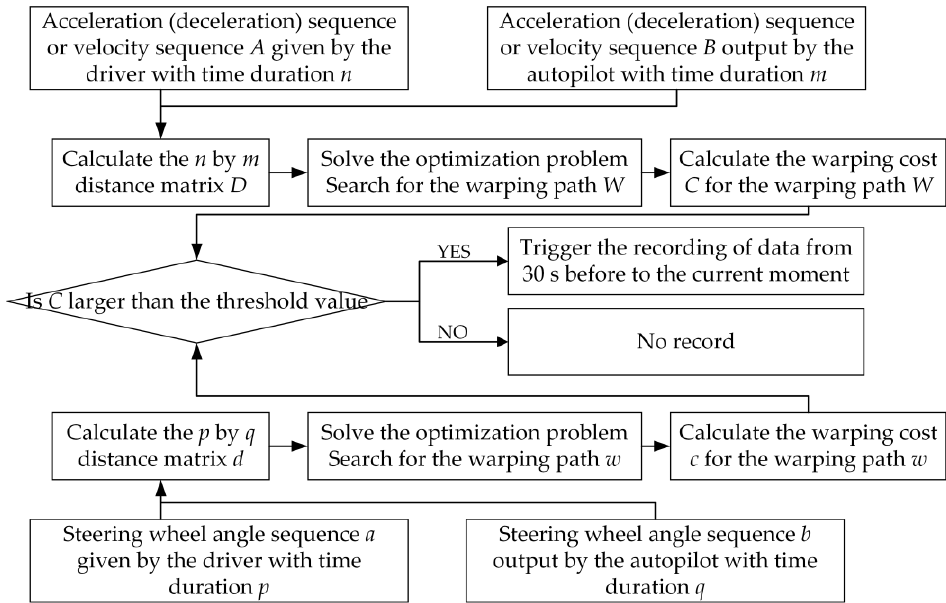
Figure 8. Flowchart of the DTW-based control command discrepancy trigger model.